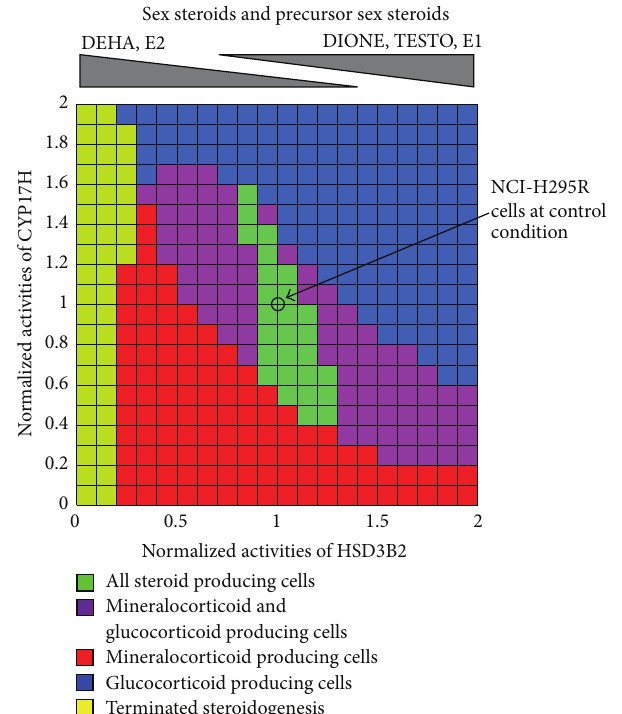
Figure 7: Metabolic categories of the steroidogenic cells determined by the balance of HSD3B2 and CYP17H activities. The two-dimensional parameter scanning analysis by the perturbation of two focused parameters clarifies the interaction and the relationship between the two parameters in the complex system. Functional cellular categories of steroidogenic cells were defined by the levels of mineralocorticoid (ALDO),glucocorticoids(DCORTandCORT),andandrogens(DHEAandDIONE)at72 hafterstimulation.EnzymaticactivitiesofHSD3B2 andCYP17werenormalizedbystandardvaluesofthesimulationmodelinNCI-H295Rcells.ScanningrangesofHSD3B2andCYP17activities were 0–200%, each 10%. Green regions are all 14 steroids produced by NCI-H295R cells. Red, blue, and purple regions are mineralocorticoid producing cells, glucocorticoids-producing cells, and both corticoid-producing cells, respectively. Yellow regions are steroidogenesis of NCI- H295R cells terminated upstream of the adrenal steroidogenesis